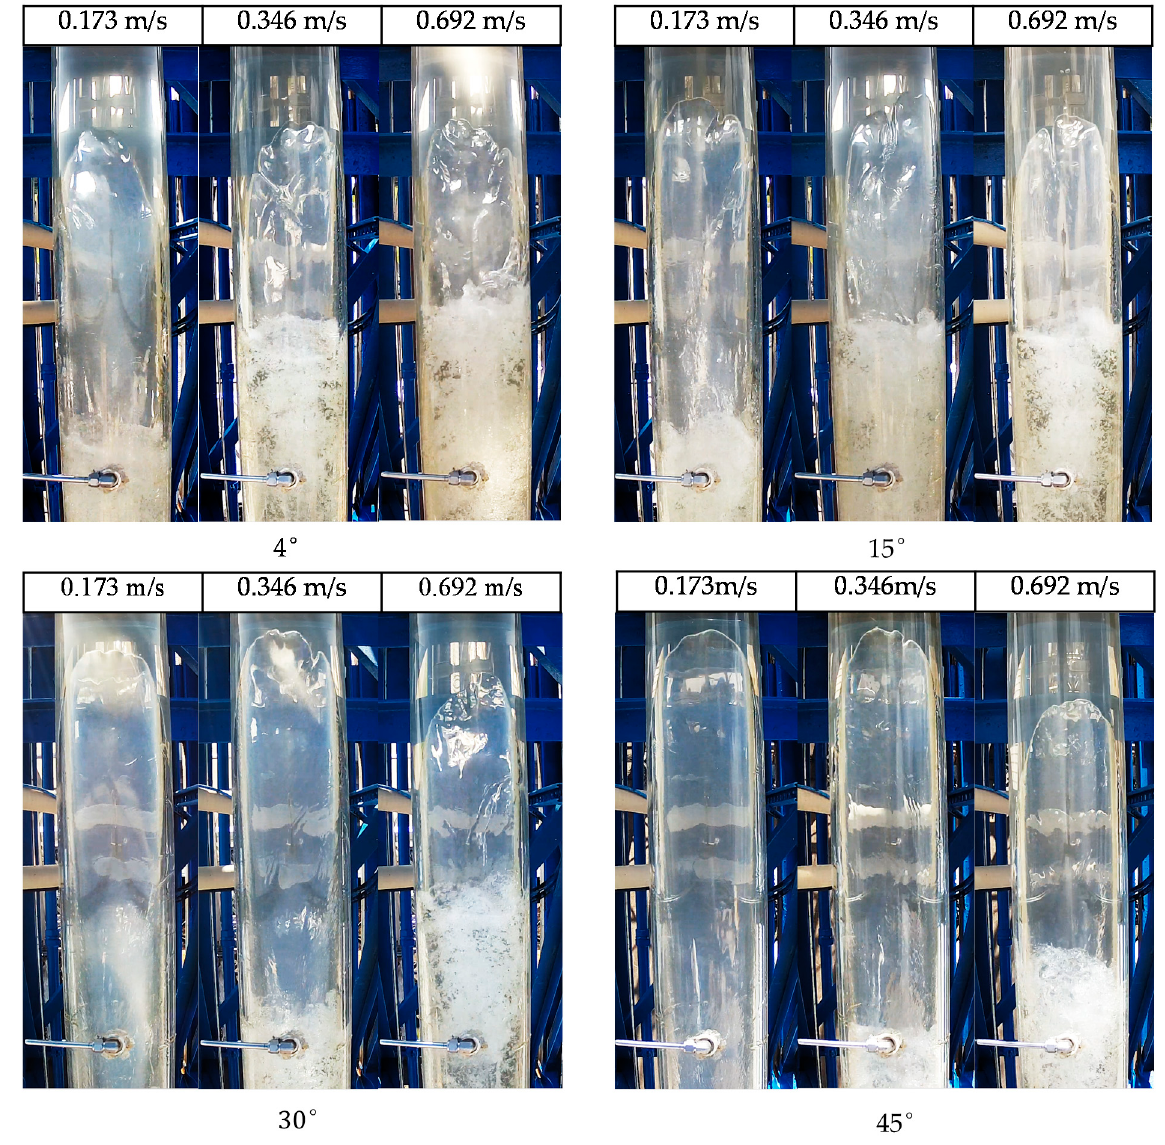
Figure 18. Influence of U L and θ on the L TB in water. Influence of (cid:2016) and (cid:1847) (cid:3013) on (cid:1838) (cid:3021)(cid:3003)